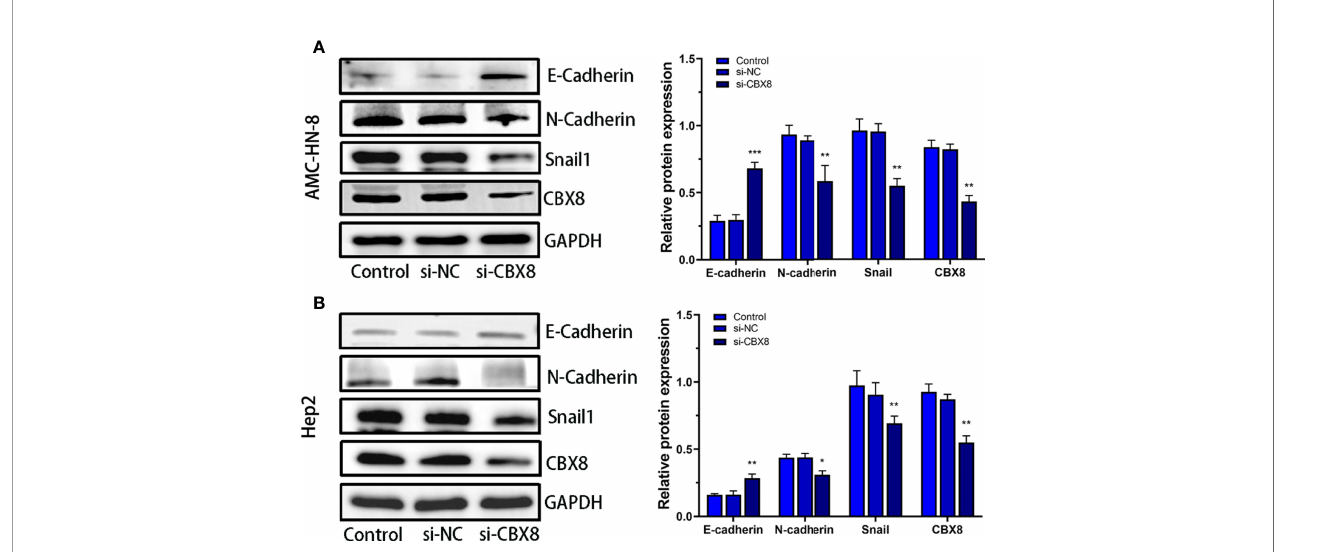
FIGURE 6 | Effect of CBX8 knockdown on EMT-related proteins. Western blotting was used to detect the expression of E-cadherin, N-cadherin and Snail1 in AMC- HN-8 cells (A) and Hep2 cells (B) and semiquantitative analysis.Each assay was repeated at least three times. Data from one representative experiment is presented as Mean ± SEM (*P < 0.05, **P < 0.01, ***P <